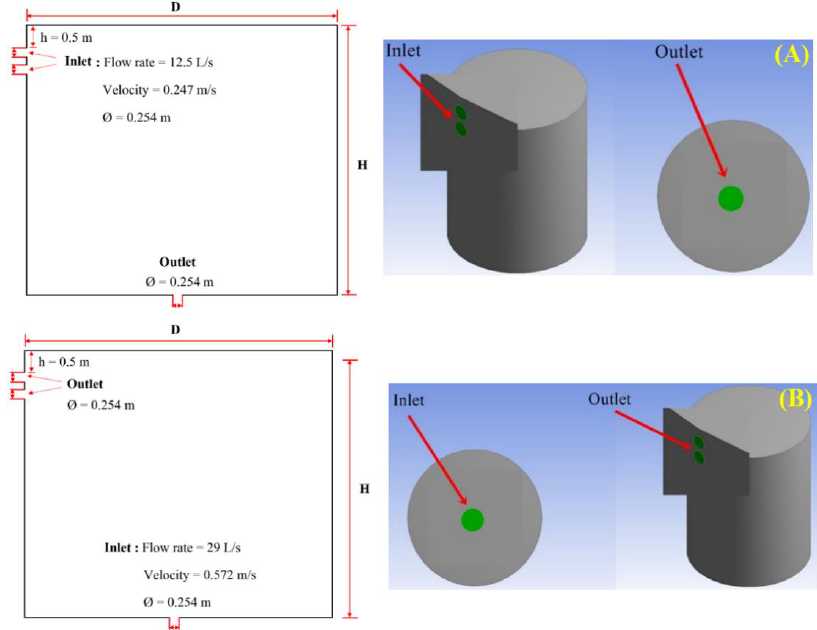
Figure 2. Details of the modeled tank. ( A ) discharging ( B ) charging.